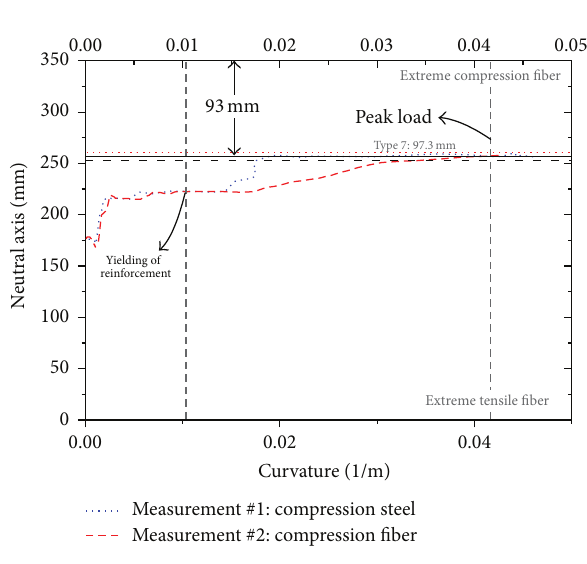
Figure 6: Change of neutral axis